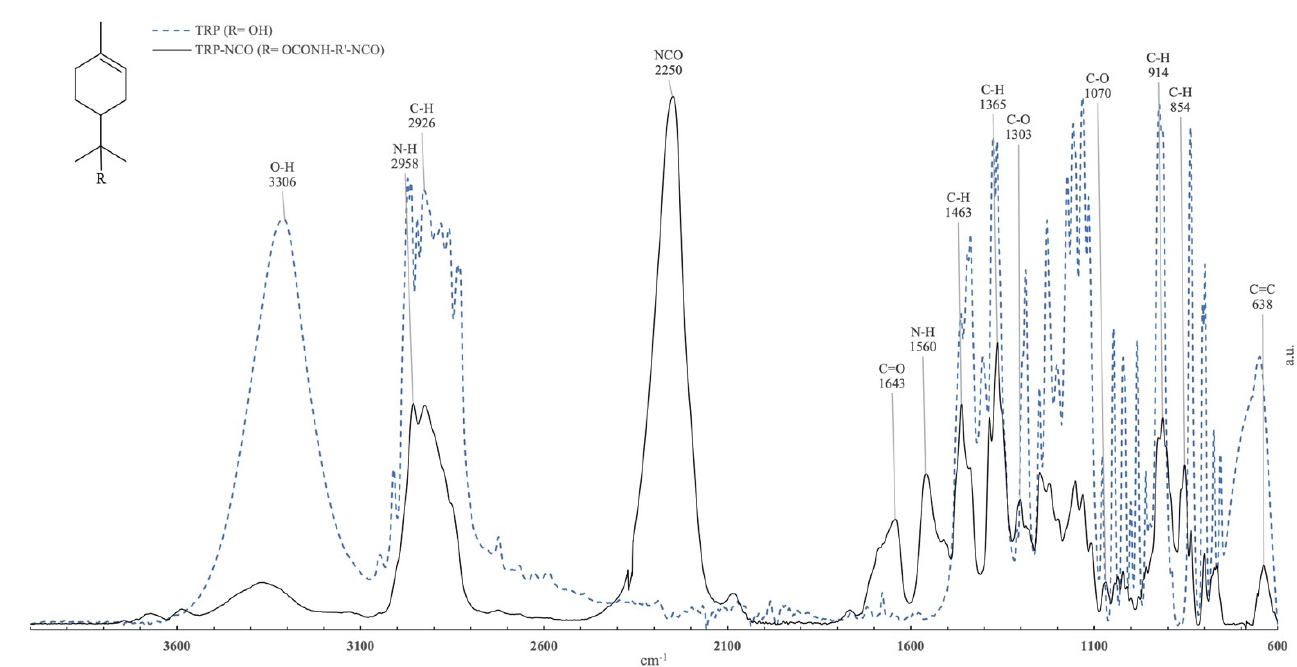
Figure 2. Normalized absorbance infrared spectra (FTIR-ATR) obtained from a-Terpineol (dashed- line, R = OH), and its isocyanate functional derivative (solid line, R = OCONH–R ′ –NCO, T–NCO).